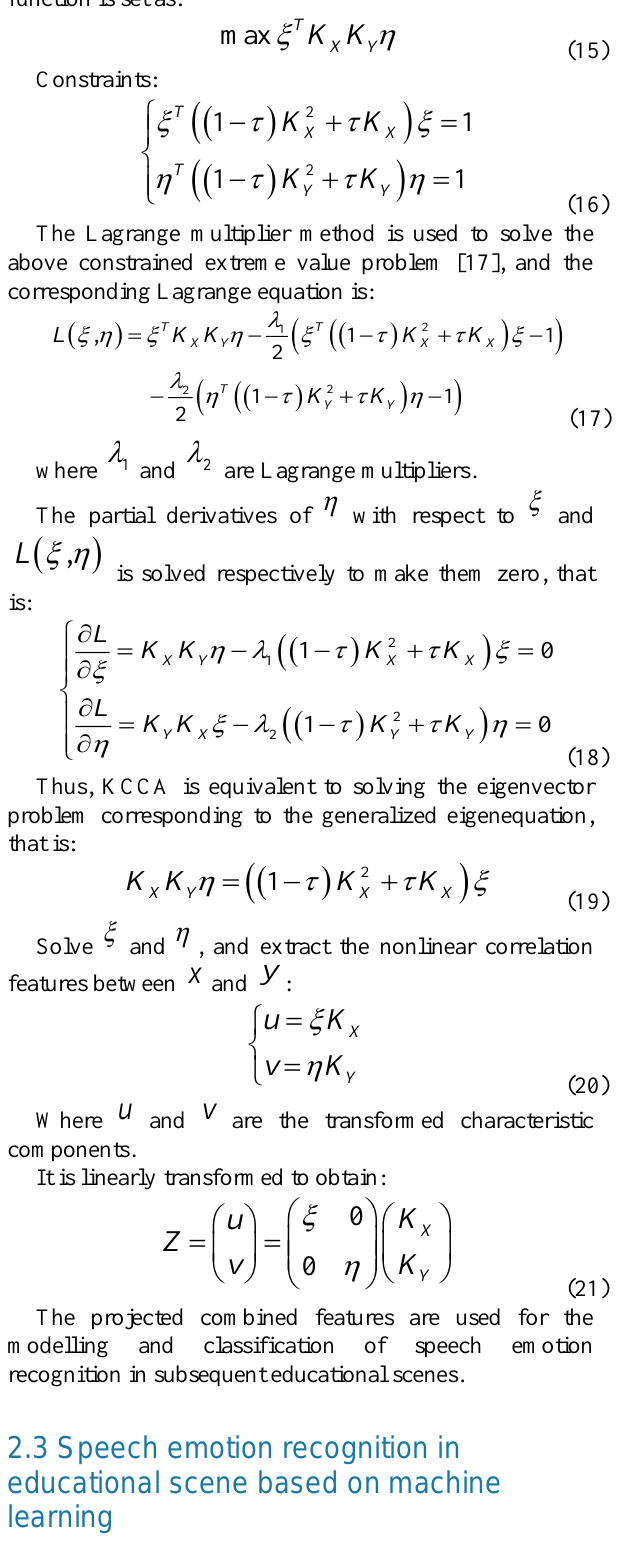
Fig 1. Implementation process of speech emotion recognition method in educational scene based on machine